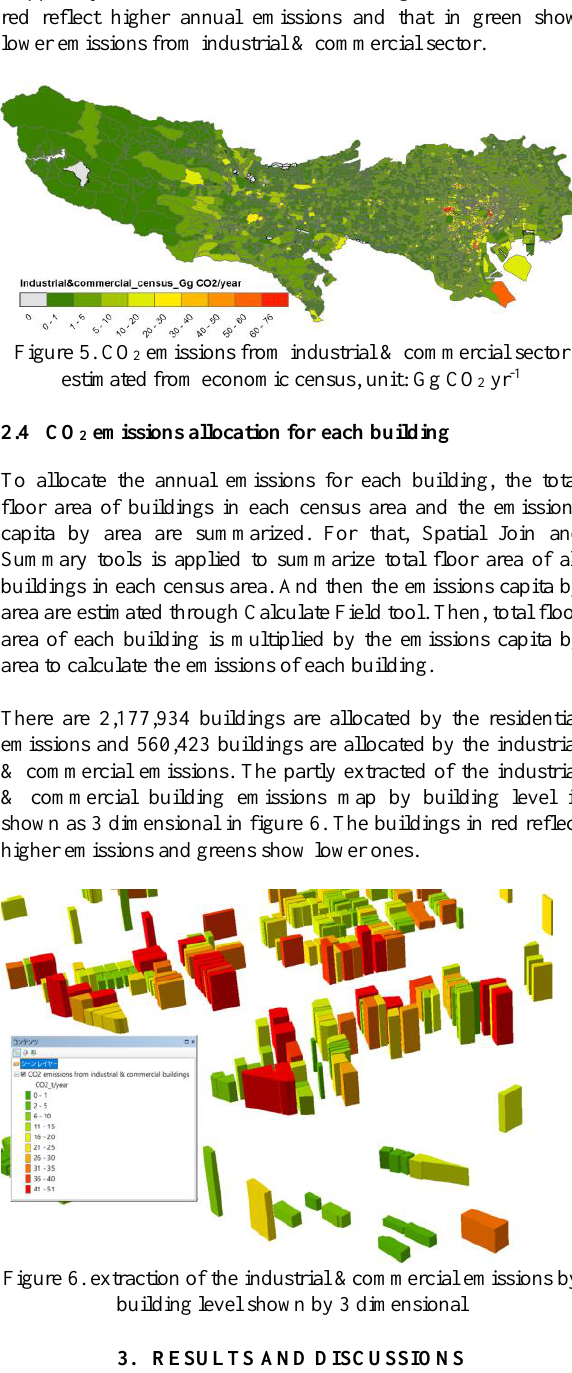
Figure 4. CO 2 emissions from residential sector estimated from population census, unit: Gg CO 2 yr -1